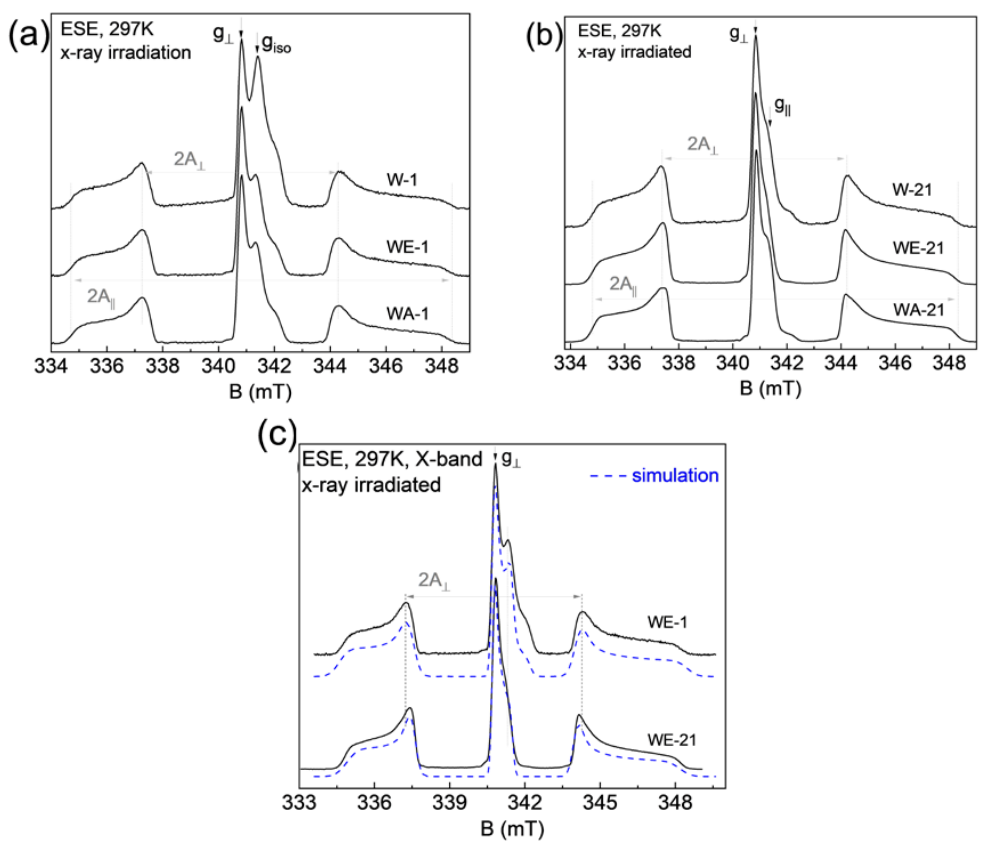
Figure 8. Room temperature, pulsed EPR spectrum of X-ray irradiated hydroxyapatite, where ( a ) a comparison of as-synthesized results for three different media is shown, ( b ) a similar representation of the results after 21 days of ripening, ( c ) a comparison of the WE (water-ethanol) results for the two ripening times, together with the corresponding theoretical simulation. Table 4. Spectroscopic parameters of the spin Hamiltonian (2) of the nitrogen radical in hydroxyap- atite.